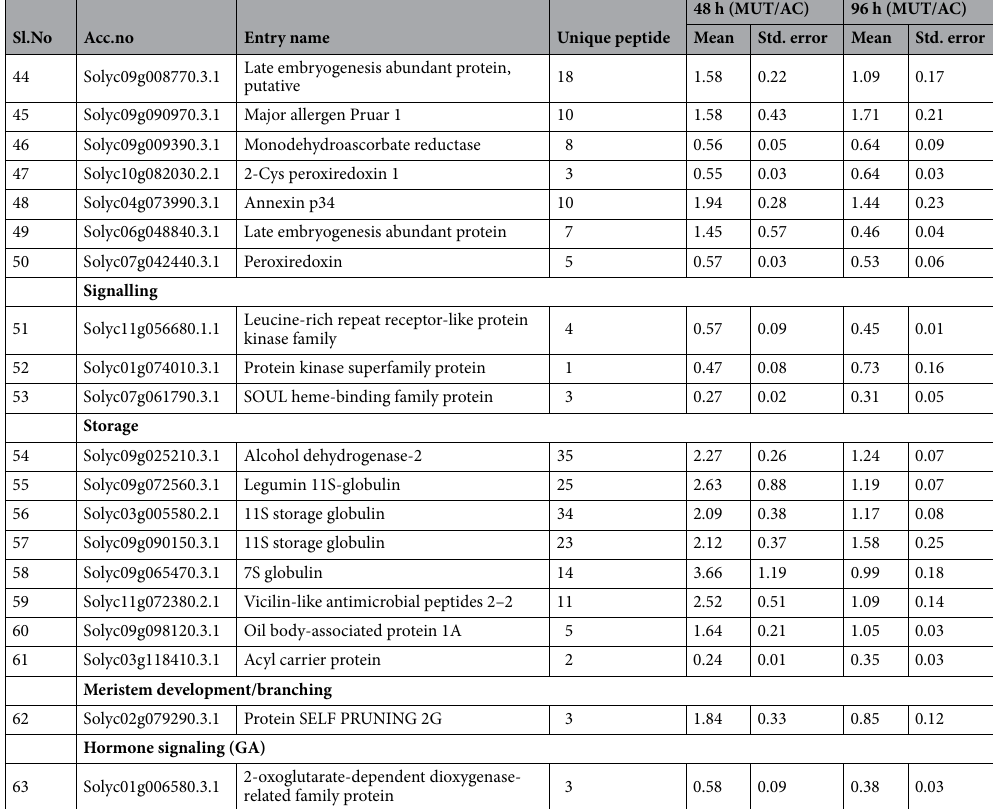
Table 3. List of differentially expressed proteins in fri mutant at different time points. A representative list of proteins from the iTRAQ data (Mean) showing a differential expression pattern. Accession number and description from the International Tomato Annotation Group (ITAG) release version